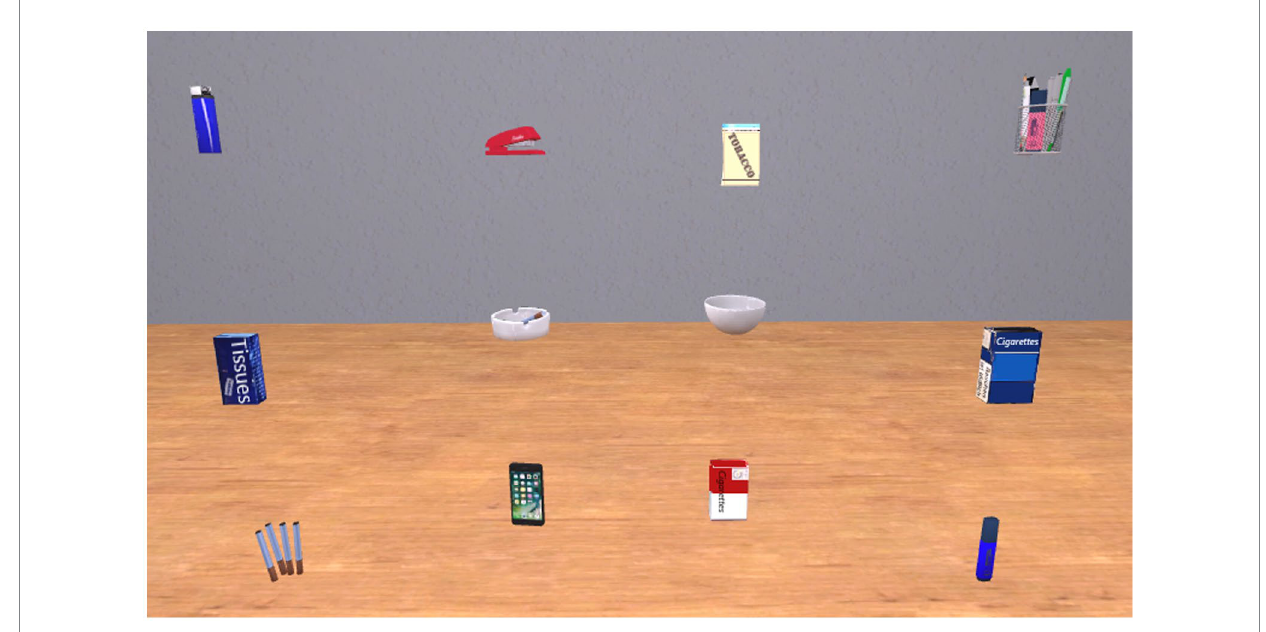
FIGURE 2 Presentation of smoking-associated and neutral stimuli in the free-viewing task. Image modified to omit